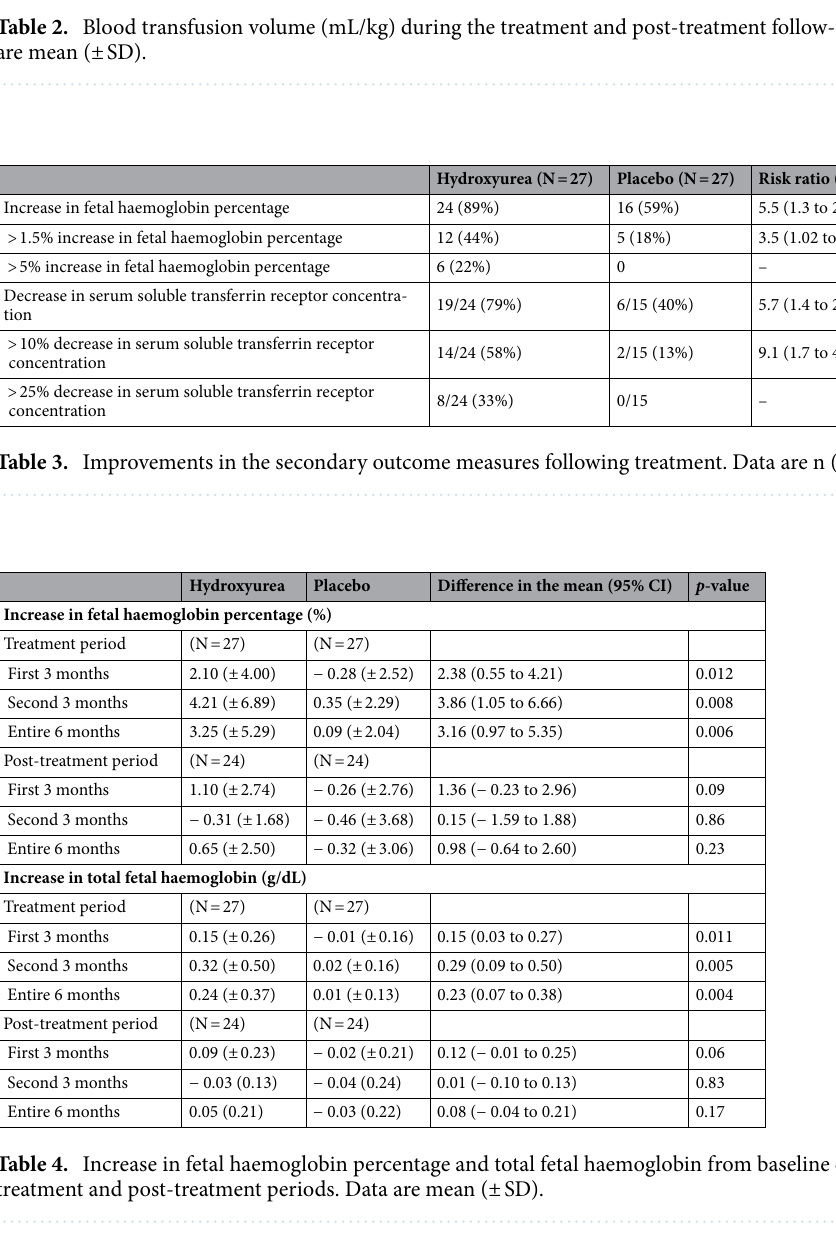
Table 4. Increase in fetal haemoglobin percentage and total fetal haemoglobin from baseline during the treatment and post-treatment periods. Data are mean (± SD).